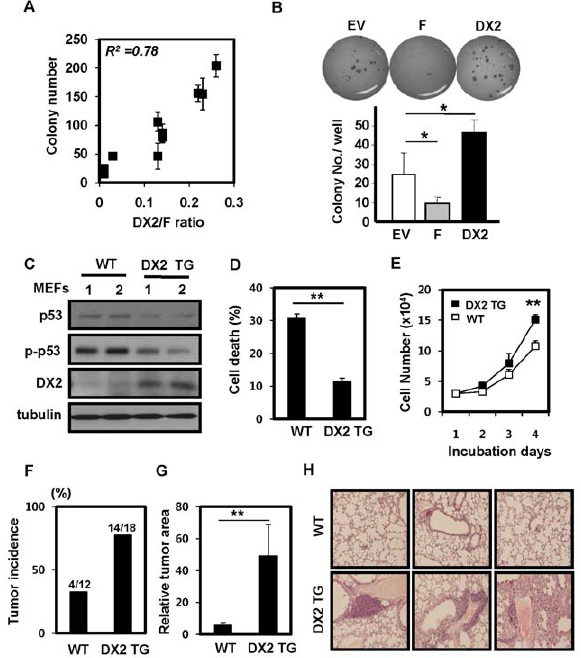
Figure 6. Oncogenic property of AIMP2-DX2. (A) BPDE-trans- formed WI-26 cells with different expression ratio of AIMP2-DX2 to AIMP2-F were tested for their propensity to anchorage-independent colony formation. The relationship between the ratio of AIMP2-DX2 to AIMP2-F and the average numbers of the produced colonies with standard deviation in each colony were displayed as dot plot. (B) WI-26 cells stably expressing EV, AIMP2-F and -DX2 were also compared for anchorage-independent colony formation. The same numbers of the three cell lines (200 cells per plate) were spread on the testing medium and the resulting colonies were counted and shown as bar graph. The experiments were repeated three times. (C) Two independent 12.5d MEFs were obtained from the wild type and AIMP2-DX2 transgenic mice and compared for the expression levels of p53 and phosphory- lation status of p53. Expression of AIMP2-DX2 was also determined by Western blot analysis. Tubulin was used as a loading control. 12.5d MEFs isolated from the wild type and AIMP2-DX2 transgenic mice were treated with adriamycin (1 m M) for 24 h and the sub-G1 populations induced by adriamycin treatment were determined by flow cytometry (D). The cell growth in completed media was also monitored (E). Susceptibility to benzopyrene-induced lung carcinogenesis was com- pared between the wild type and AIMP2-DX2 transgenic mice by tumor incidence (F) and area (G). The area was represented by the numbers given in Bio-Image J 2.0. (H) Three lungs were isolated from the wild type and AIMP2-DX2 transgenic mice and subjected to hematoxylin and eosin staining.